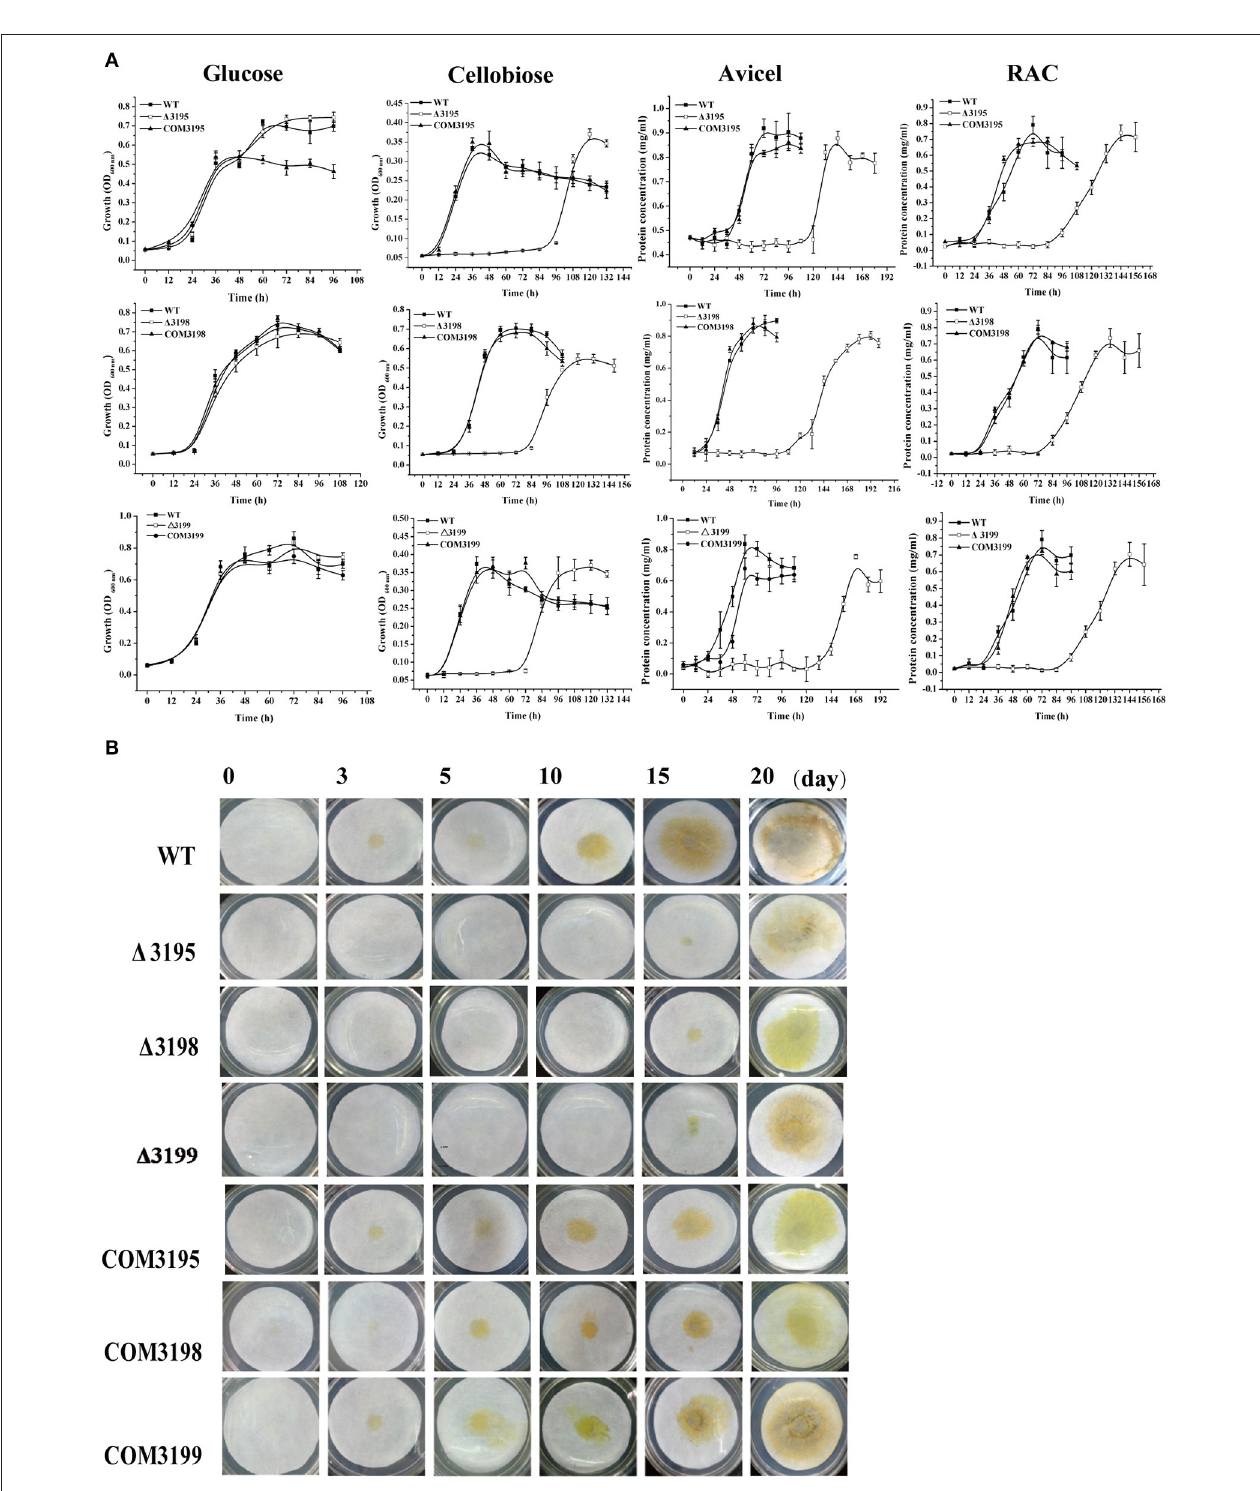
FIGURE 2 | Growth analyses of C. hutchinsonii WT, t2s mutant strains and the individual complemented strains in liquid PY10 medium containing different carbon sources as indicated (A) and on solid plate with filter paper on top of PY10 agar (B) . The growth assay was performed in duplicate (with the same results) and one representative result is